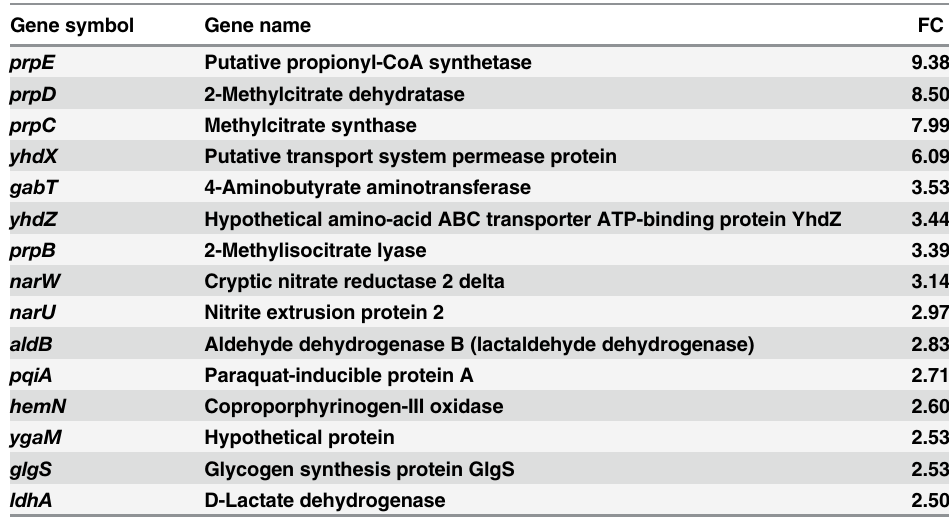
Table 4. Differentially up-regulated (FC > 2.50) genes in Δ tynA .